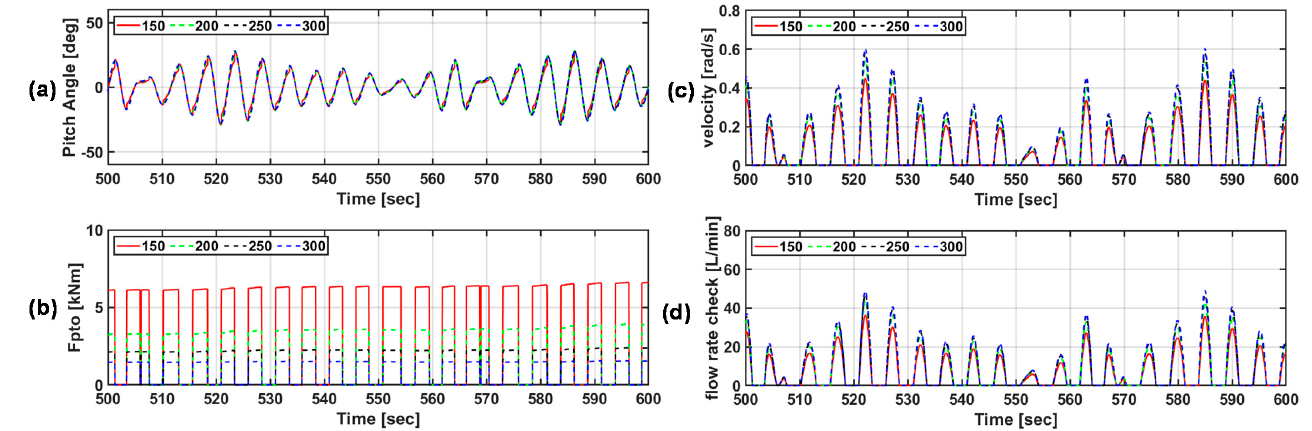
conditions, because the input energy changes rapidly, a large difference occurs in the load